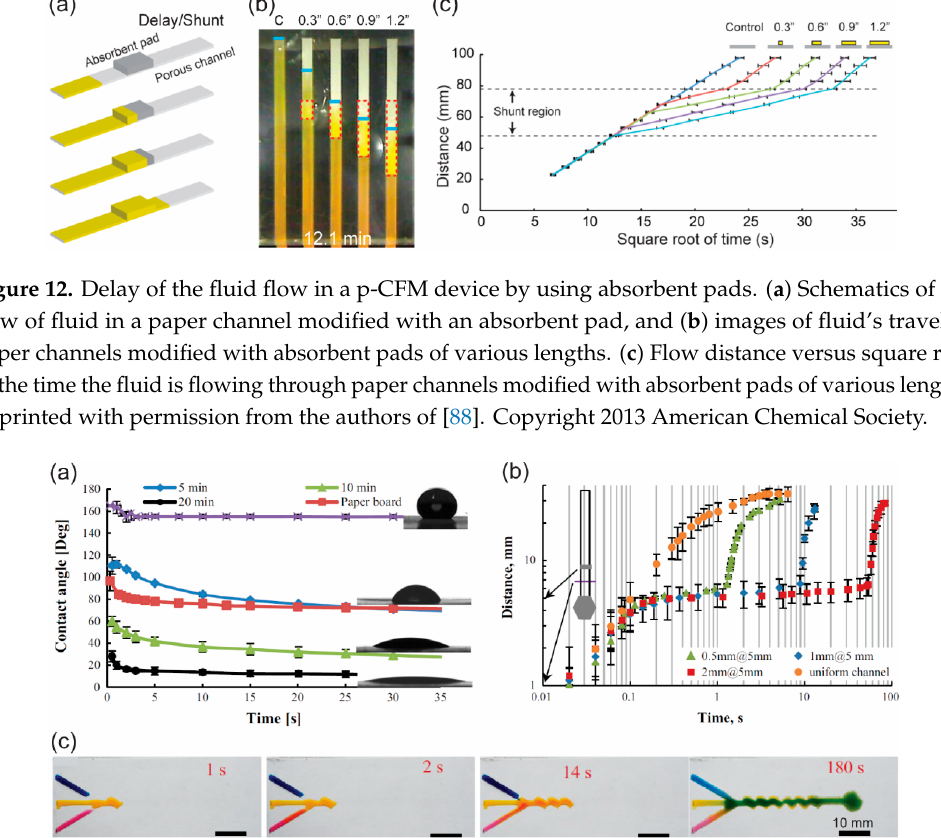
Figure 12. Delay of the fluid flow in a p-CFM device by using absorbent pads. ( a ) Schematics of the flow of fluid in a paper channel modified with an absorbent pad, and ( b ) images of fluid’s travel in paper channels modified with absorbent pads of various lengths. ( c ) Flow distance versus square root